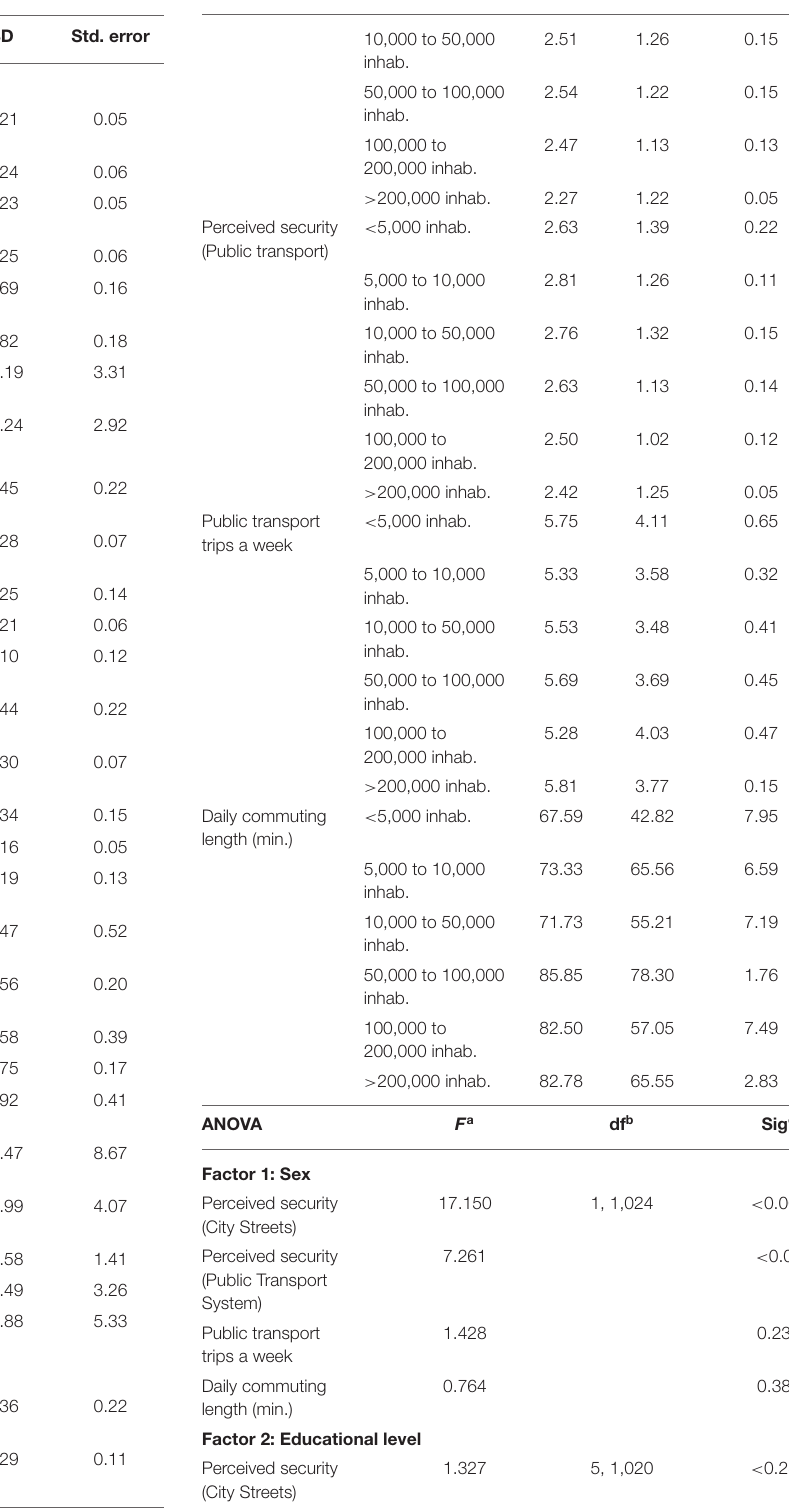
TABLE 4 | Inter-group descriptive data (above) and mean comparisons (ANOVA; below) for security perception and urban trip-related factors according to sex, educational level, and city/town size interval